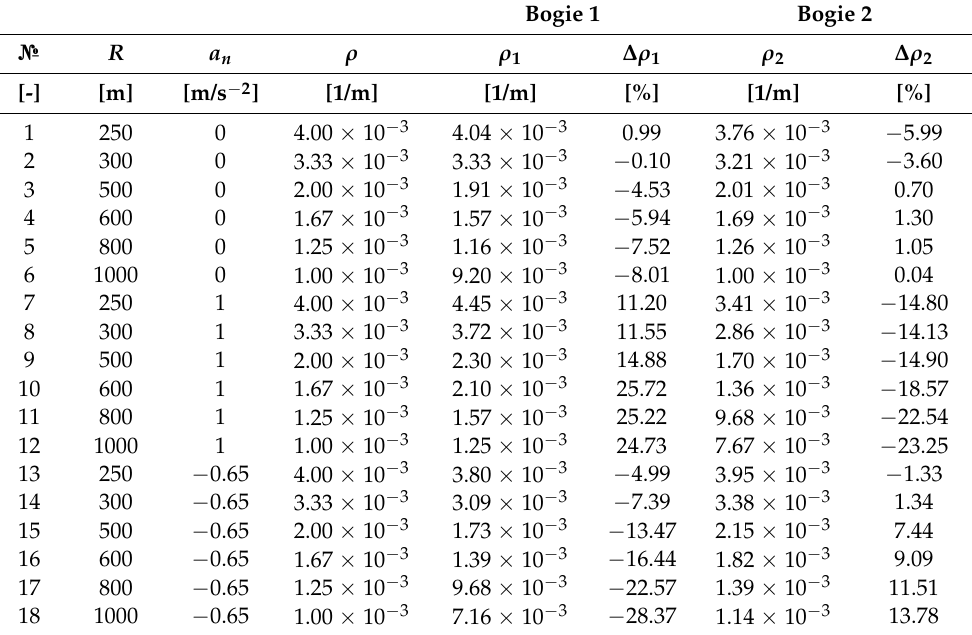
Table 6. Calculated track curvature for low friction